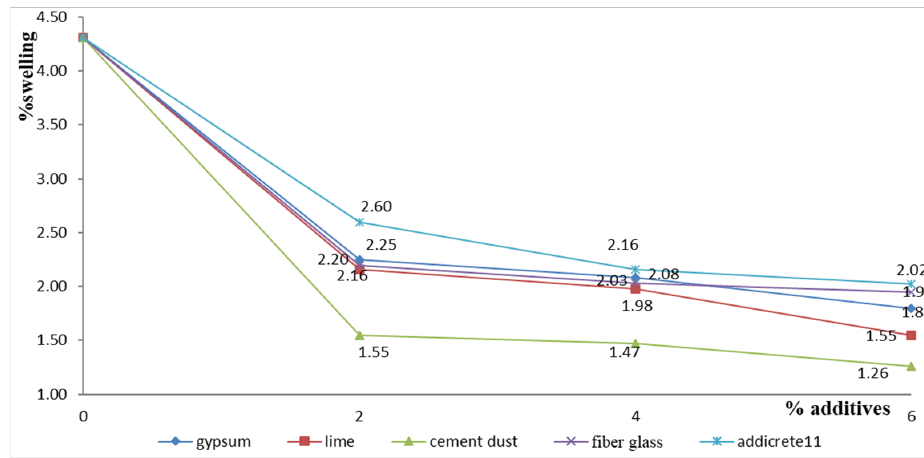
Figure 15. Effects of additives on swelling percentage.